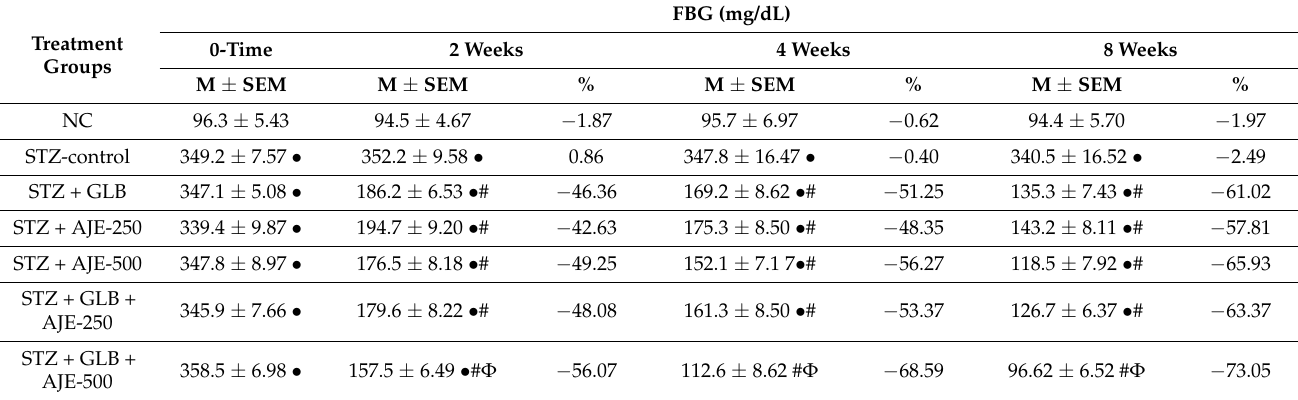
Table 3. Effect of GLB, AJE, and their combination on serum levels of FBG in STZ-diabetic rats.